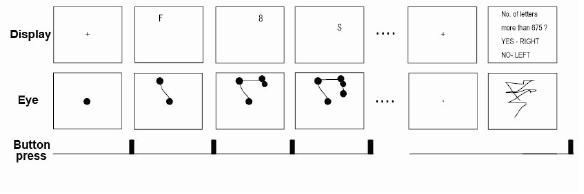
Figure 1. Schematic illustration of the tasks. Top row: After an initial fixation cross, a letter or a digit was presented in one of 16 display locations. In the end of the stimulus sequence, a question display was presented. Different questions were used depending on task conditions. In the figure, the question belonging to the category-count task is shown. Middle row: Participants were asked to follow each stimulus with eyes (fixations are represented as black circle), then pressed right or left buttons. Bottom row: The button presses were required to start the next stimulus; in the category- judgment and location-judgment conditions, the button presses were categorization responses (See text for details of task